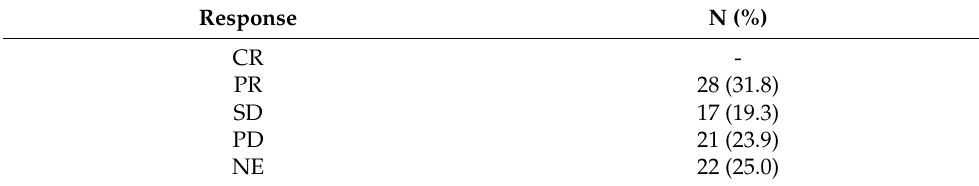
Table 3. Treatment outcomes in the overall population.